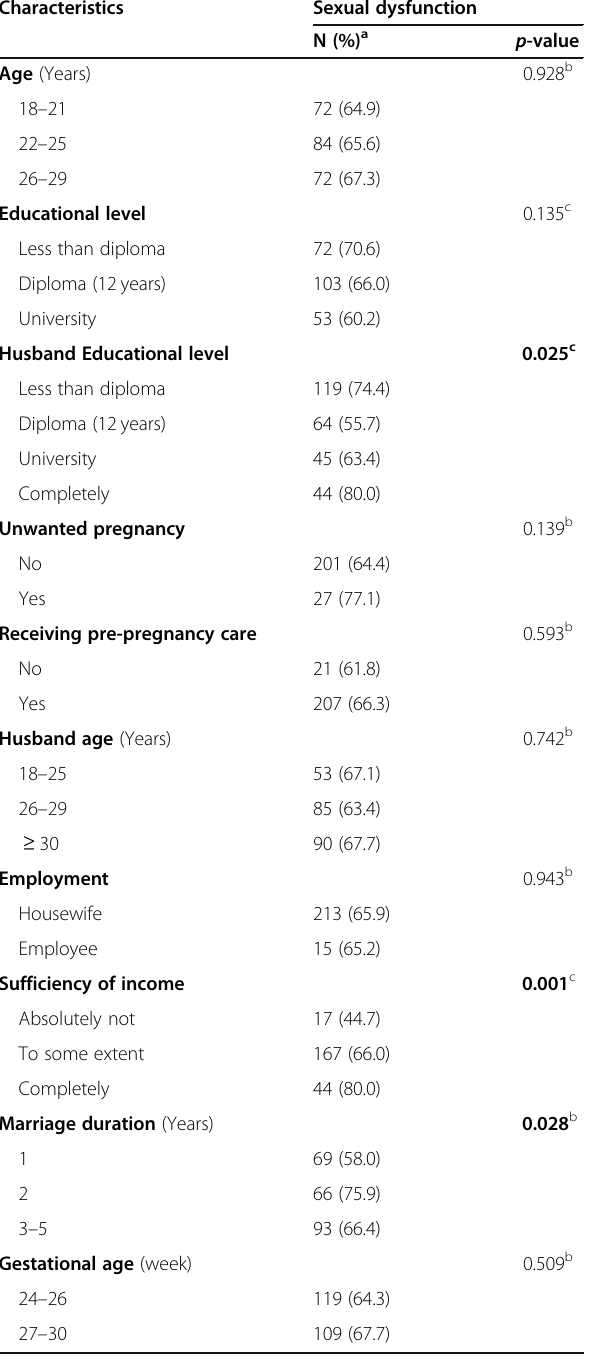
Table 5 Correlation between sexual dysfunction and intimate partner violence and socio-demographic characteristic